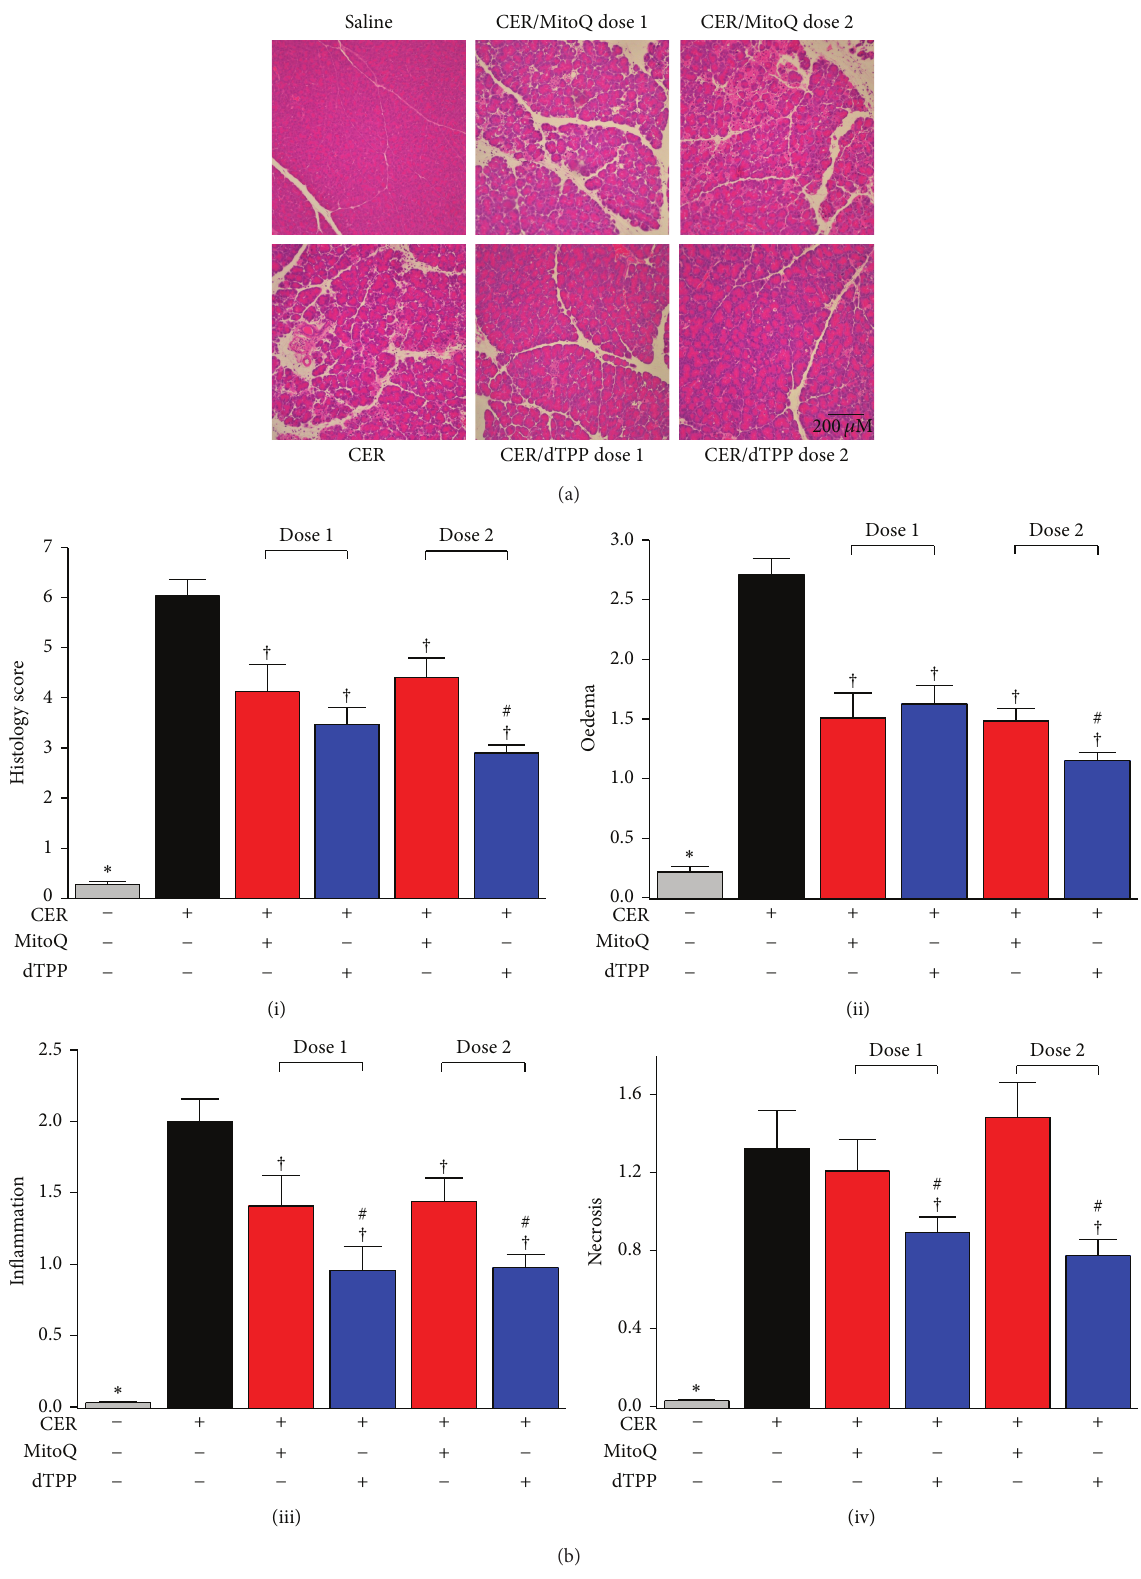
Figure 4: Effects of MitoQ on histopathological changes of CER-AP. (a) Representative H&E images for all experimental groups (magnification 200x). (b) Histopathology scores: (i) overall, (ii) oedema, (iii) inflammation and (iv) necrosis. ∗ 𝑃 < 0.05 when compared with all other groups, † compared with CER-AP alone group, # compared with MitoQ group at the same dose. Values are the mean ± SEM ( 𝑛 = 6 mice per